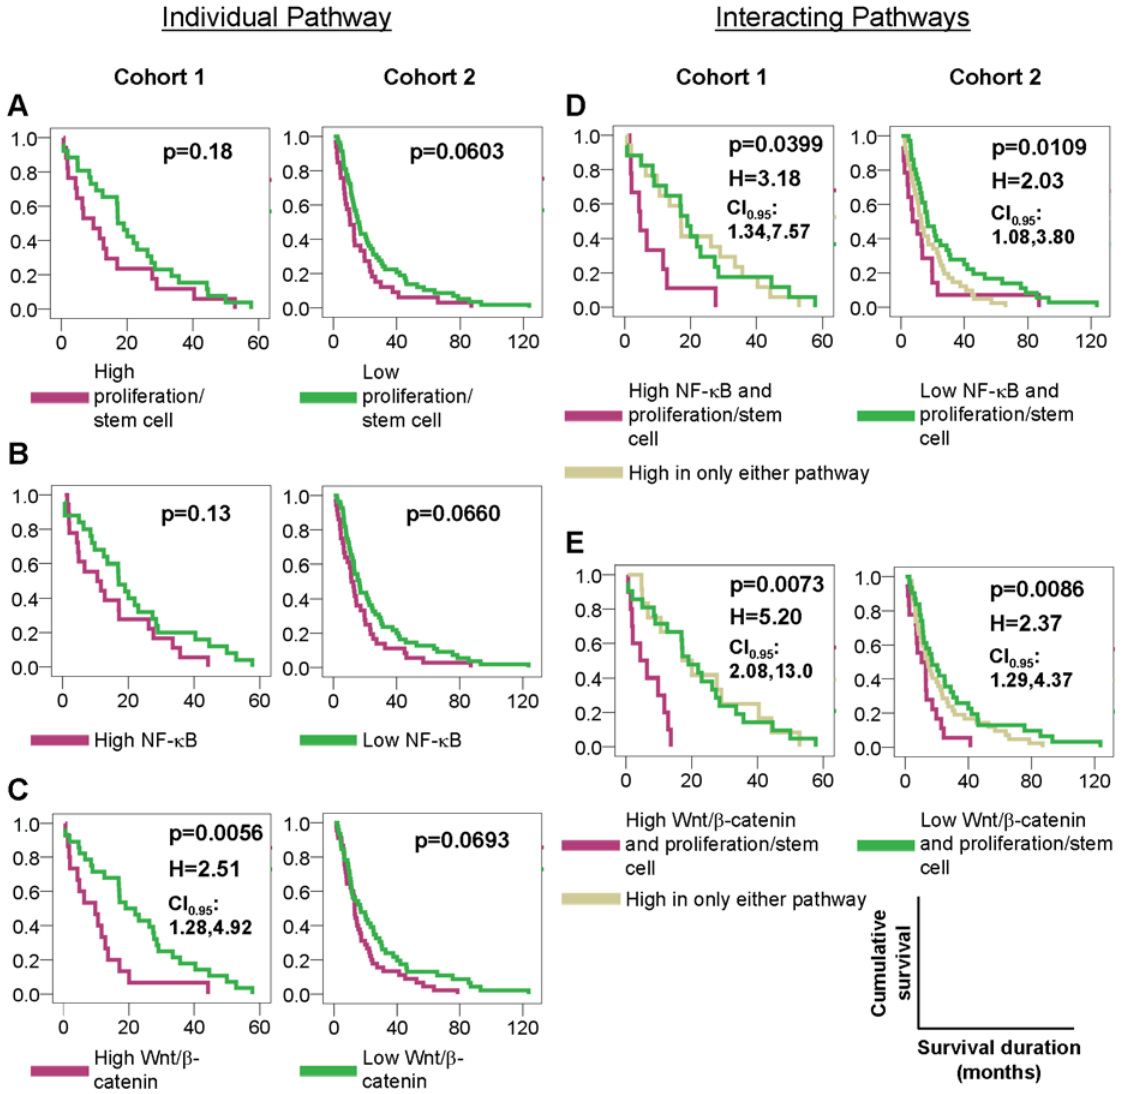
Figure 5. Pathway interactions influence patient survival in gastric cancer. Kaplan-Meier survival analysis of Australia and Singapore cohorts (Heatmaps A and B in Figure 2) between patient groups stratified by predicted pathway activation status. Cohort 3 was not included in the survival analysis as it is much smaller than Cohorts 1 and 2 (31 tumors compared to 70 and 200), making it unreliable for statistical analysis. (A–C) Effects of individual pathways. Patients were stratified by (A) proliferation/stem cell signatures alone, (B) NF- k B signatures alone, and (C) Wnt/ b -catenin signatures alone. (D) and (E) Effects of pathway interactions. Patients were stratified by (D) NF- k B and proliferation/stem cell signatures, and (E) Wnt/ b -catenin and proliferation/stem cell signatures. For both the NF- k B and Wnt/ b -catenin signatures, the significance of the survival difference or death hazard was markedly enhanced by the addition of pathway prediction information from the proliferation/stem cell signatures. The outcome metric was duration of overall survival. H: death hazard indicating the ratio of the mortality rate of patients showing high activation level of single pathway (or both of two pathways) to the mortality rate of patients showing low activation level of single pathway (or both of two pathways). All death hazard ratios are significant at p , 0.01. CI 0.95 : 95% confidence intervals for death hazard